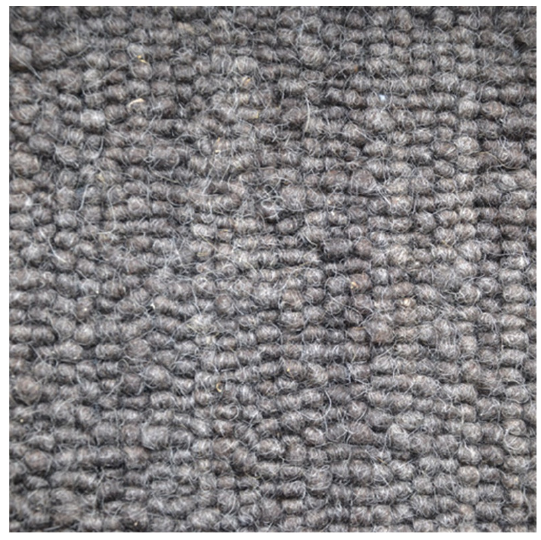
Figure 6. Tufted fabrics manufactured from core rug yarn.